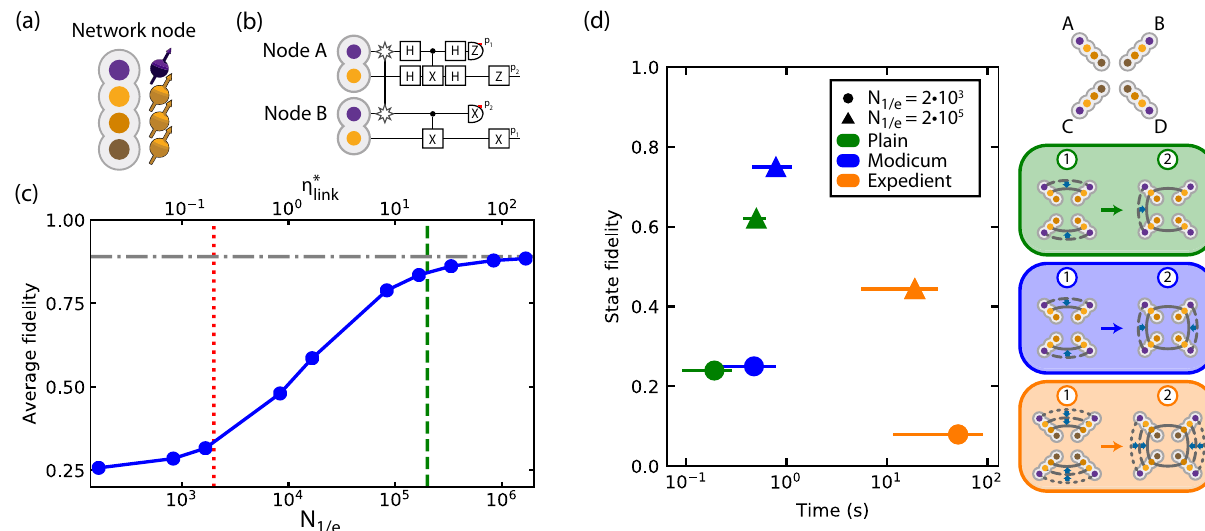
Fig. 4 Simulated quantum-network performance. a Diagram of a single network node comprising an electron spin (purple) and up to three nuclear spins (orange tones). b Quantum circuit for a CNOT operation between nuclear spins in separate network nodes. p 1,2 are feed-forward operations. The gate is performed deterministically: the nuclear-spin states are prepared, then entanglement is distributed, and the gate is performed independent of the number of entanglement attempts required and for all measurement outcomes. c Simulated performance of the non-local CNOT protocol (see ( b )) for a range of data qubit lifetimes. The red and green lines mark memory lifetimes of N 1/e = 2 × 10 3 and 2 × 10 5 , respectively. The grey line is the limit of the average CNOT fi delity, F av = 0.89, set by error sources other than memory decoherence, see text. Error bars are smaller than markers. d Simulated performance for creation of a GHZ state between four network nodes, for three different protocols as schematised on the right. The innermost qubits in the schematics could host the encoded logical information of the distributed surface code, but are not used here. Further details of each protocol are given in Supplementary Note 9. The horizontal error bars in ( d ) indicate the distribution of durations taken for each protocol to succeed (68.2% con fi dence